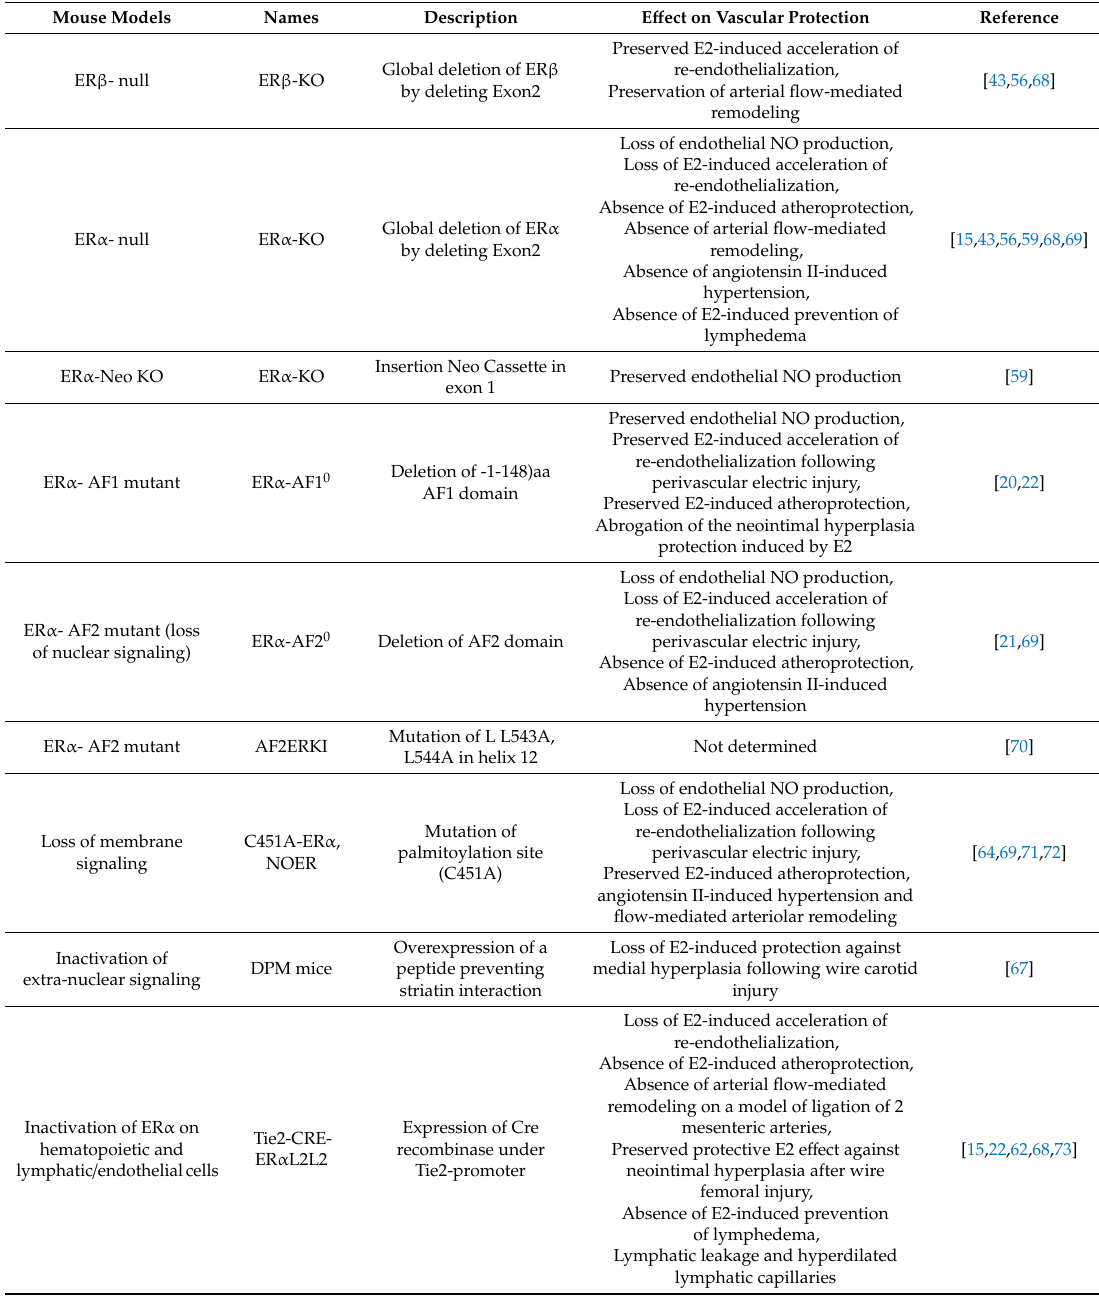
Table 1. Summary of vascular e ff ects in mouse models of E2 and pharmacological